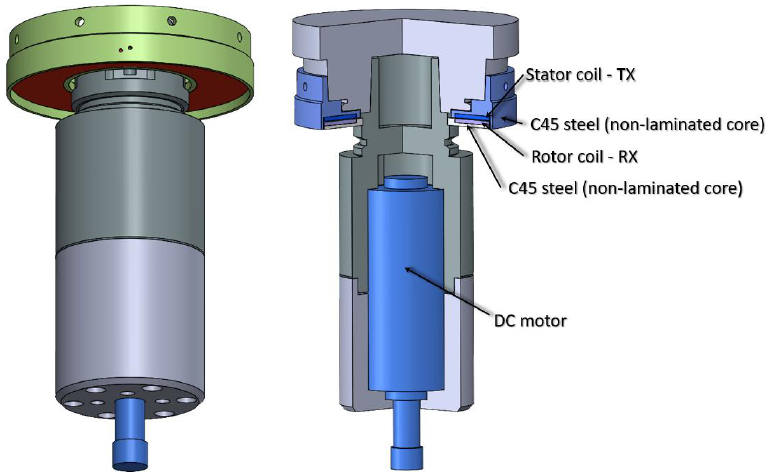
Figure 3. CAD model of the technological accessory prototype.